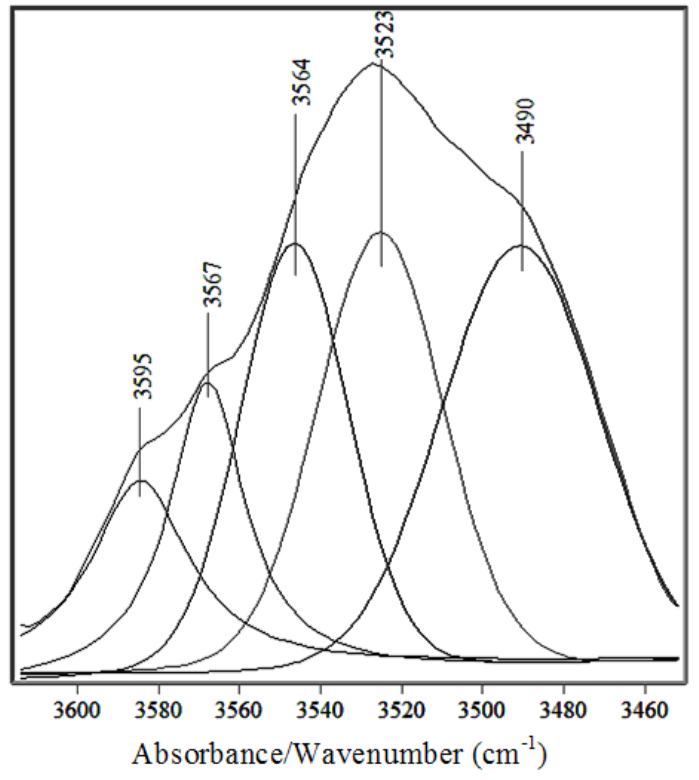
Fig. 5 3650 – 3400 cm − 1 curve-fitted IR-spectrum of nadolol in acetonitrile solution. The molar magnetic susceptibility χ M of the dinuclear complex decreases with an increase of the temperature which is typical for paramagnetic substances. At the same time the Curie-Weiss law is not obeyed in the whole range studied (2-295 K) and χ M T vs T plot (Fig. 7) shows a course characteristic for antiferromagnetically coupled Cu(II) centers [31]. The values of the effective magnetic moment, μ eff , calculated using the expression μ eff = 2 .